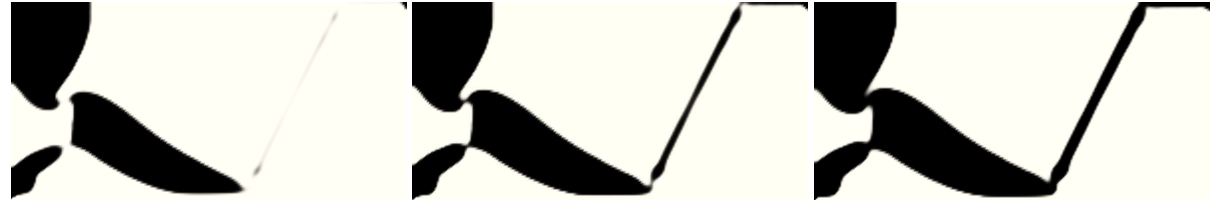
Figure 3. Three threshold projections, eroded, intermediate and dilated, obtained with thresholds η = 0 . 6 , 0 . 5 and η = 0 . 4, respectively. The design is obtained using large displacements deterministic optimisation formulation with threshold η = 0 . 5 and volume constraint 30% of the original volume imposed on the dilated projection at η = 0 . 3. The objective is c = − 29 . 12 µ m and the projection parameter is β = 32.